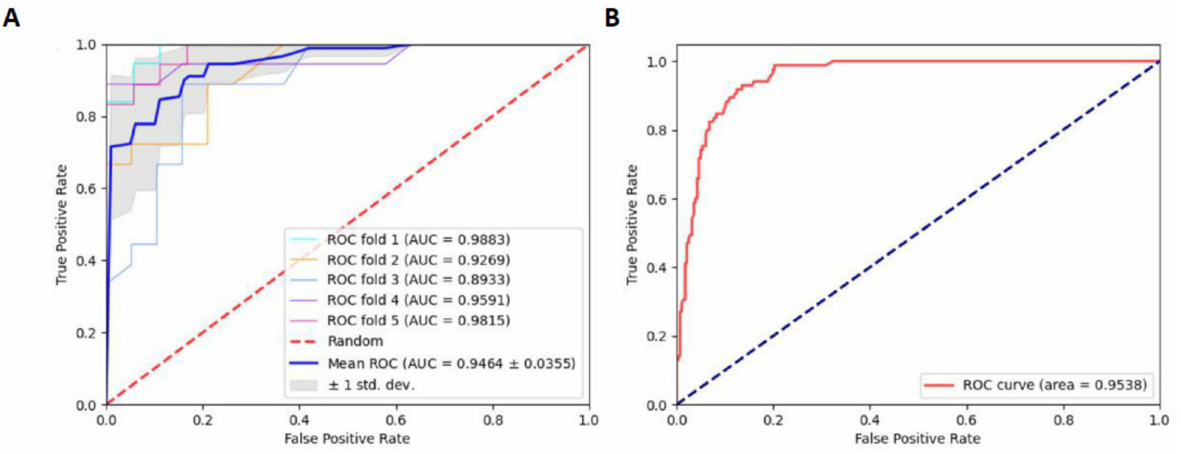
Figure 3. ( A ) ROC curve of the 5-fold CV of experiment I. ( B ) ROC curve of independent tests of experiment